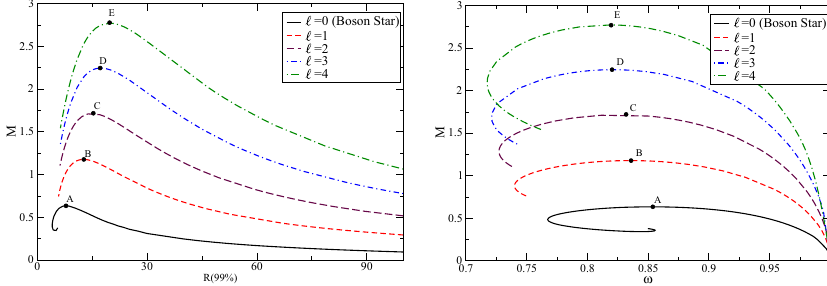
Fig. 11 ‘ -boson stars: (Left) Total mass as a function of the effective radius for equilibrium con fi gurations of different angular momentum number, denoted here as l . Note that the mass increases more quickly with k than the radius, and hence the compactness increases. (Right) Total mass as a function of the frequency of oscillation for the same con fi gurations as in the left panel. Reproduced with permission from Alcubierre et al. (2018), copyright by